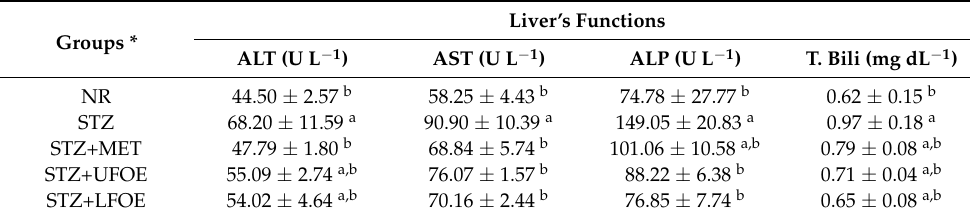
Table 6. Effect of orally administrated fermented oat extract on liver functions in Streptozotocin- induced diabetes in rats (mean ± SE), n =